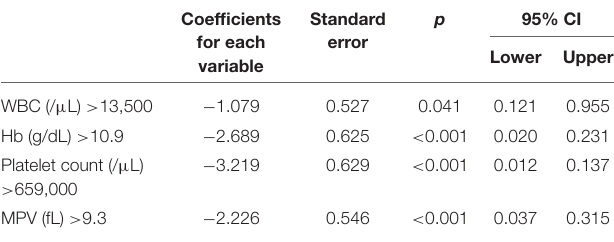
TABLE 3 | The results of multivariate analysis by forward stepwise.